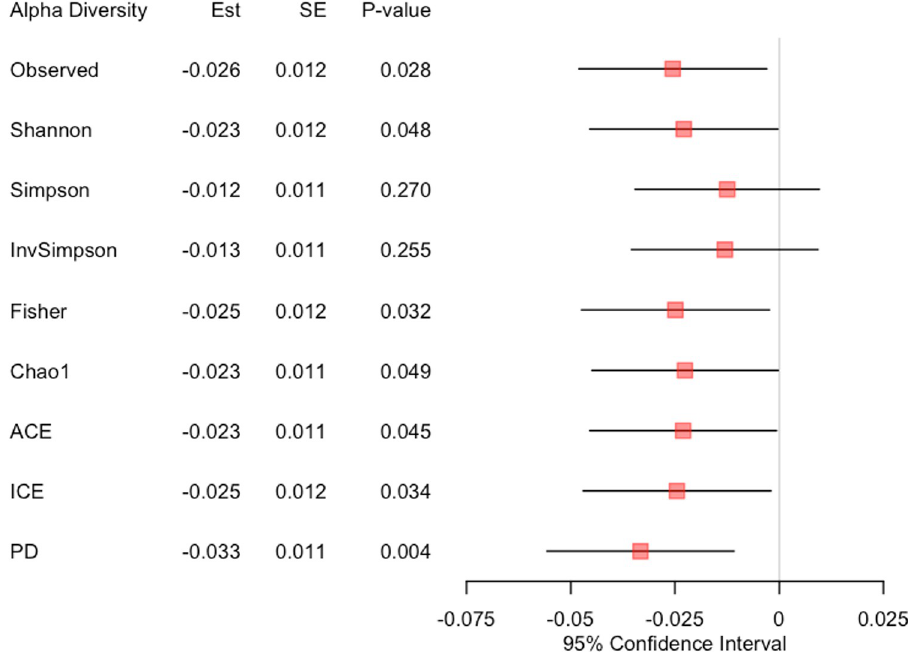
Fig 2. The results for alpha diversity analysis. Est represents the estimated coefficient, and SE represents the standard error.